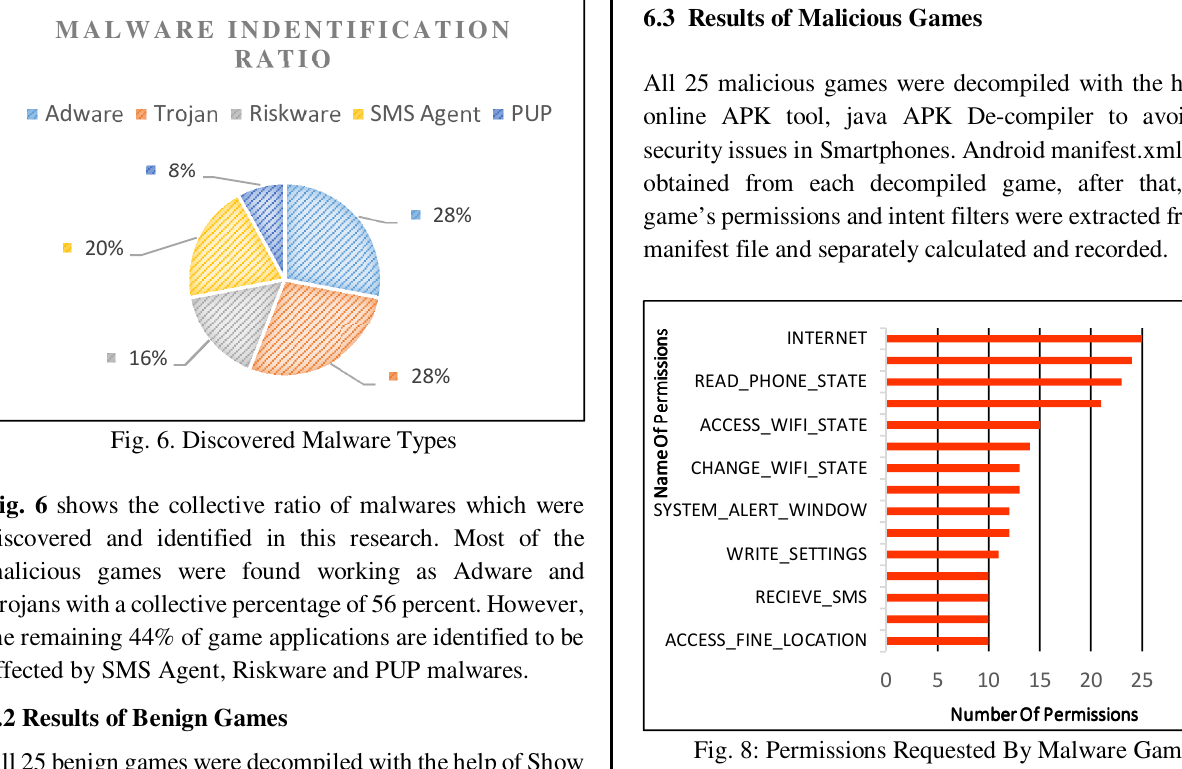
Fig. 8: Permissions Requested By Malware Game